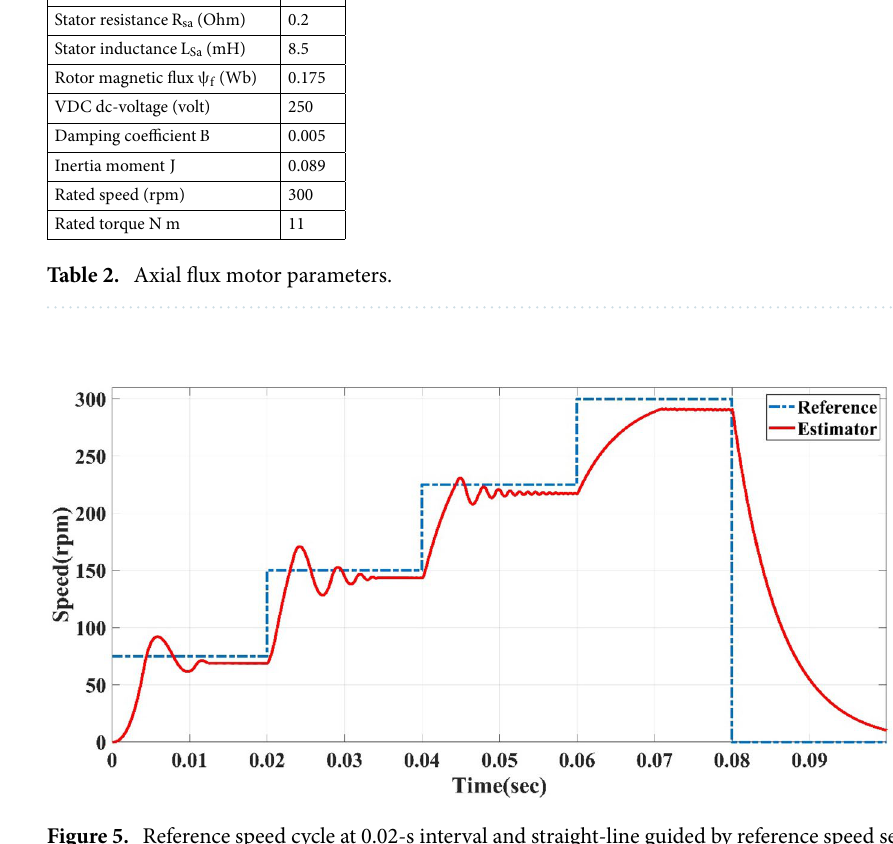
Figure 5. Reference speed cycle at 0.02-s interval and straight-line guided by reference speed sensorless estimator of AFPMSM.